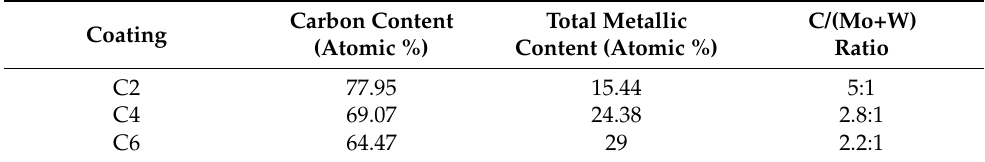
Figure 3. Elemental distribution of Mo-W-C coatings detected by GDOES analysis: ( a ) C2, ( b ) C4, ( c ) C6 and ( d ) summary of elemental composition. Table 2. C/(Mo+W) ratio as calculated from GDOES analysis .